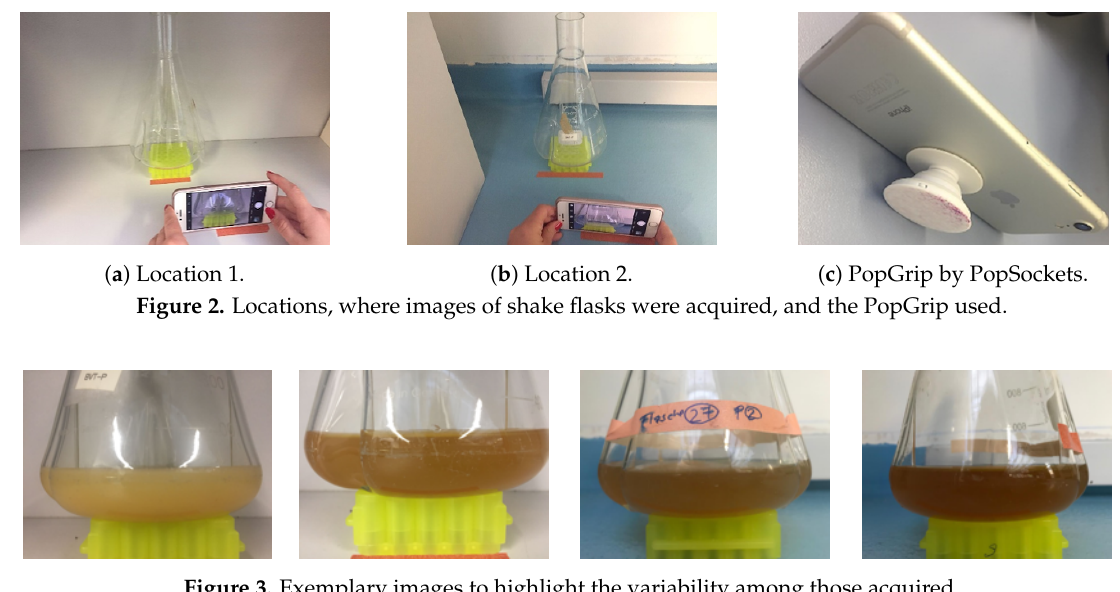
Figure 3. Exemplary images to highlight the variability among those